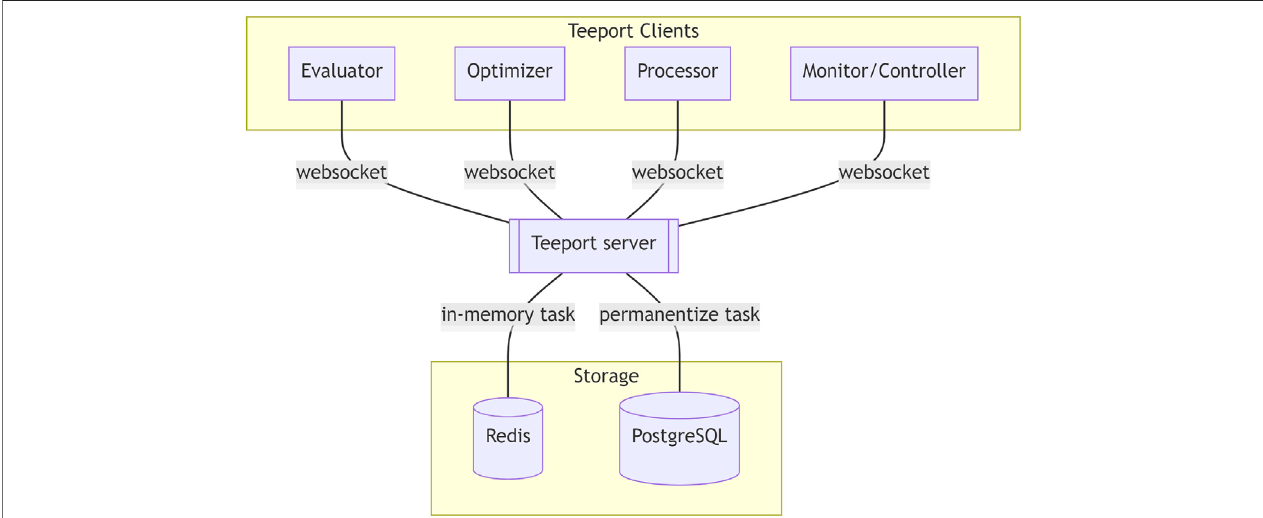
FIGURE 4 | Architecture of Teeport. The Teeport clients are connected to the Teeport backend server through the WebSocket protocol. The Teeport backend server processes and forwards the messages between the clients, while storing the optimization related data that fl ows through it in the storage, such as the Redis and PostgreSQL database for data